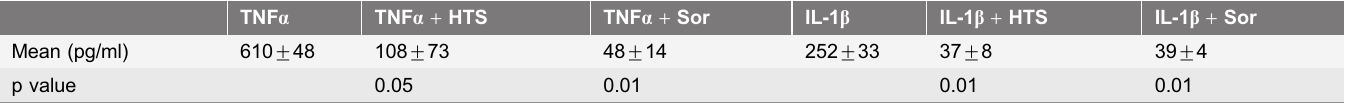
Table 2. HOsm treatment inhibits intracellular RANTES levels in parallel with overall chemokine release